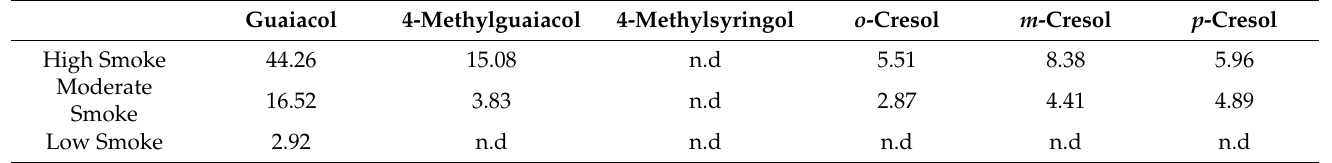
Table 1. Concentrations of smoke marker phenols in the three wines used for sensory analysis. All values reported in µ g/L. Guaiacol 4-Methylguaiacol 4-Methylsyringol o -Cresol m -Cresol p -Cresol High Smoke 44.26